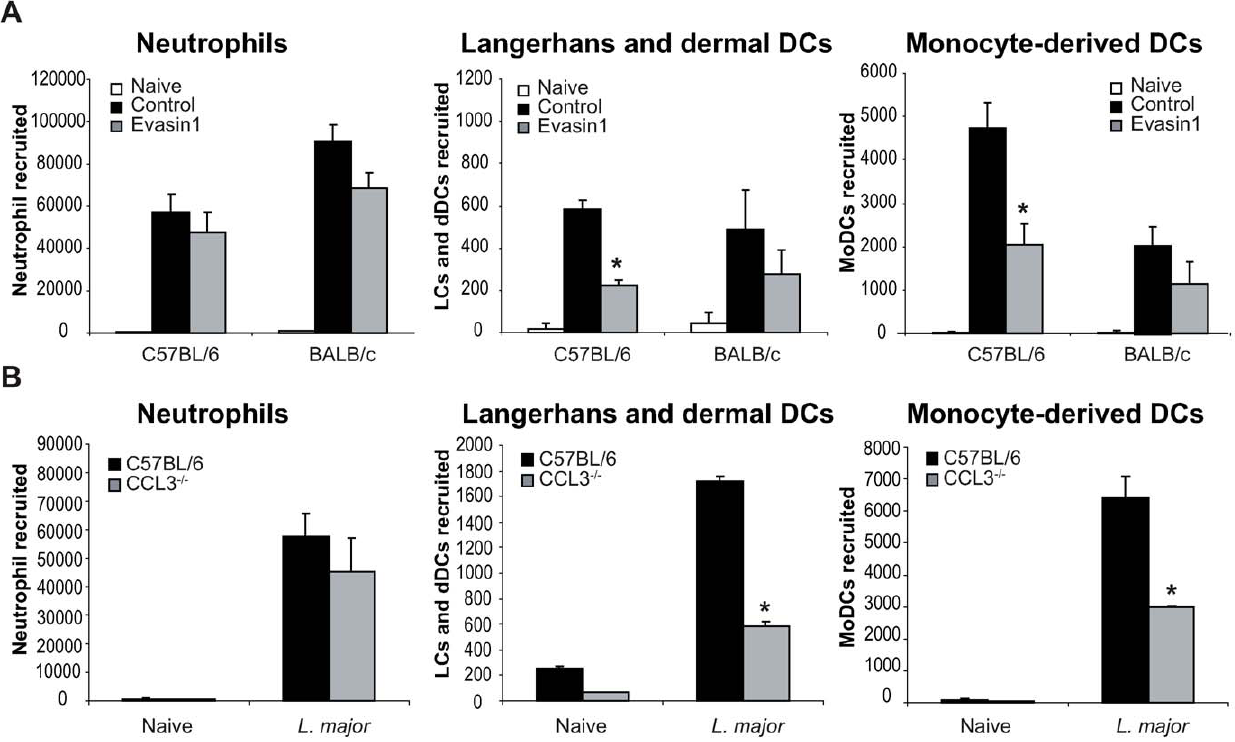
Figure 5. CCL3 is essential for early DC trafficking/recruitment to the site of infection following L.major inoculation. (A) C57BL/6 and BALB/c mice were injected i.p. with Evasin-1, a chemokine binding protein that neutralizes CCL3. Twenty four hours post L. major inoculation, the number of neutrophils, Langerhans and dermal DCs, and monocyte-derived DCs, spontaneously emigrating out of ear explants was measured and compared to that obtained from ear explants from mice similarly infected but which were not given Evasin-1. * : p , 0.05 between mice treated or not with Evasin-1. (B) 24 hours after infection i.d. with L. major , the number of leukocytes emigrating out of ear skin explants of CCL3 2 / 2 mice was compared to that measured in similarly infected C57BL/6 ear explants. The number of neutrophils, Langerhans and dermal DCs, and monocyte- derived DCs is presented as the mean 6 SEM (n=4 for Evasin-1 treated mice, and n=6 for CCL3 2 / 2 mice) and are representative of three experiments. *: p , 0.05 between CCL3 2 / 2 and C57BL/6